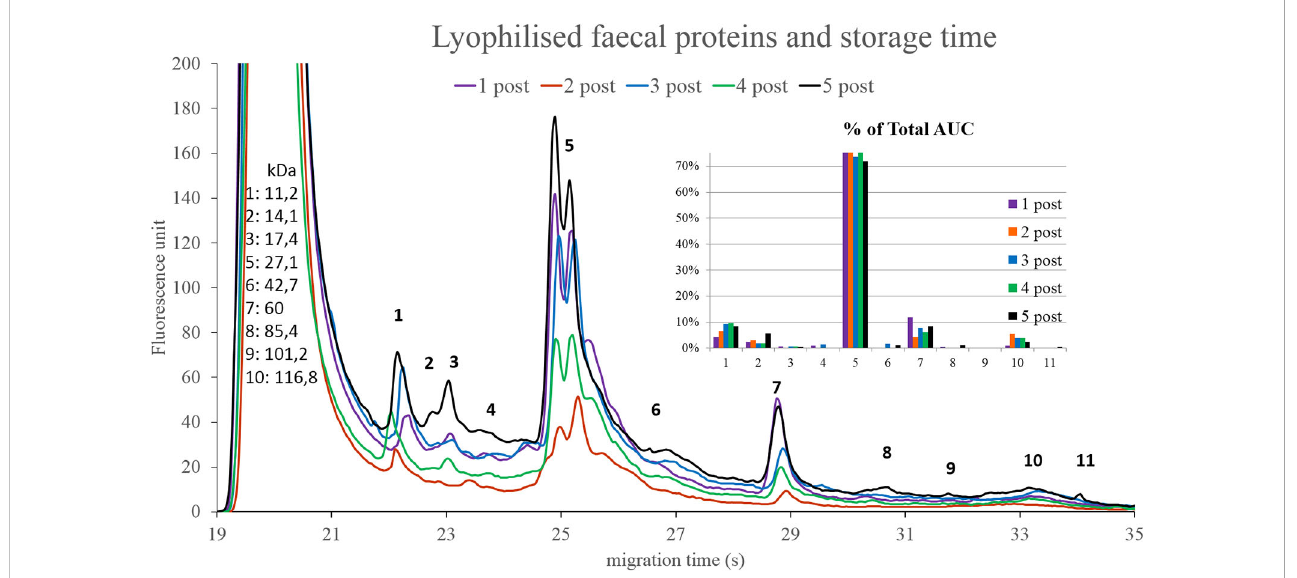
FIGURE 10 Protein compositions of lyophilised donor stool samples over time. The numbered data points refer to different components. The molecular weights of the components can be seen on the left side in kilodaltons. The bar graph on the right side shows the relative abundance of these components in the